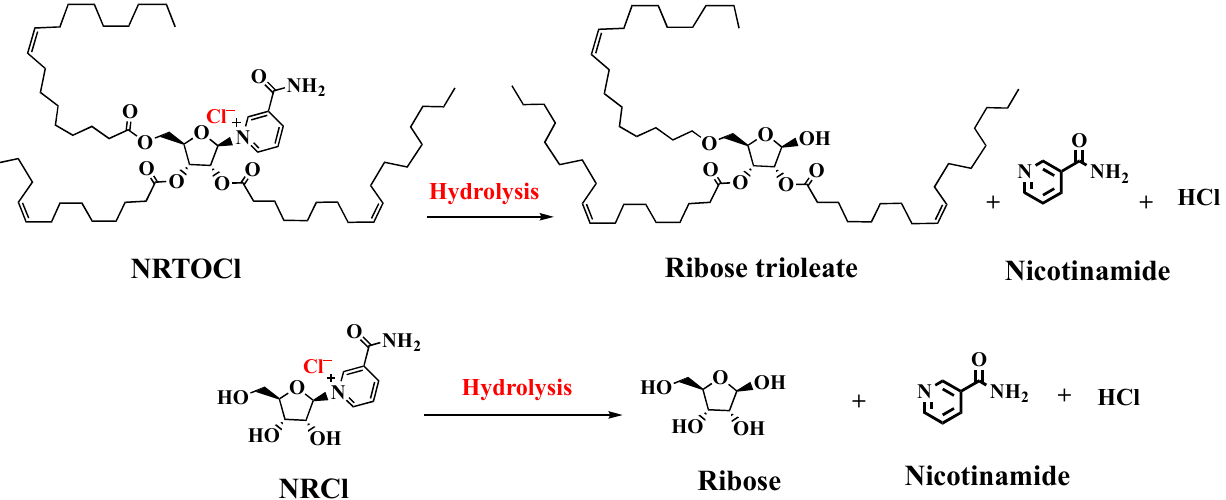
Figure 2. Comparison of NRTOCl stability with NRCl in DI water at 35 °C. We found that both NRTOCl and NRCl release nicotinamide during hydrolysis (Scheme 3), and by measuring the released amount of nicotinamide in each sample by HPLC, we were able to calculate the remaining amounts of NRTOCl and NRCl. Release of NRCl from NRTOCl was not detected, which signifies that the oleate ester groups in NRTOCl are not hydrolyzed.